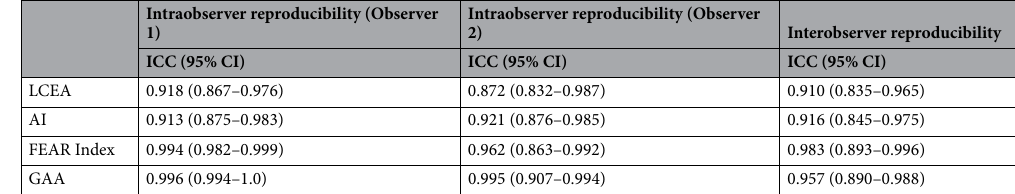
Table 2. Intra- and Interobserver Reproducibility of the GAA in 20 Patients a . a AI acetabular index, FEAR